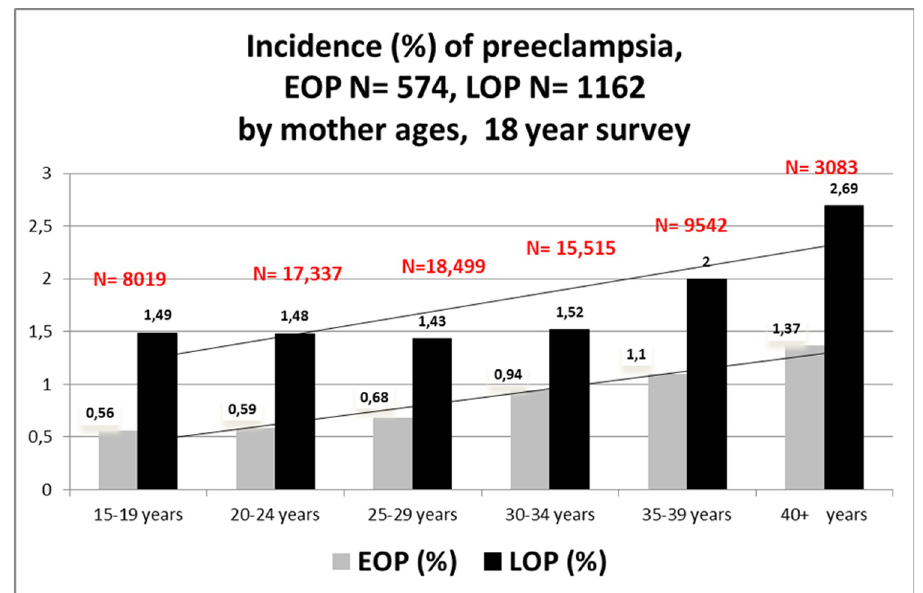
Fig 4. Incidence of preeclampsia, EOP (N = 574), LOP (N = 1,162) by mother ages.